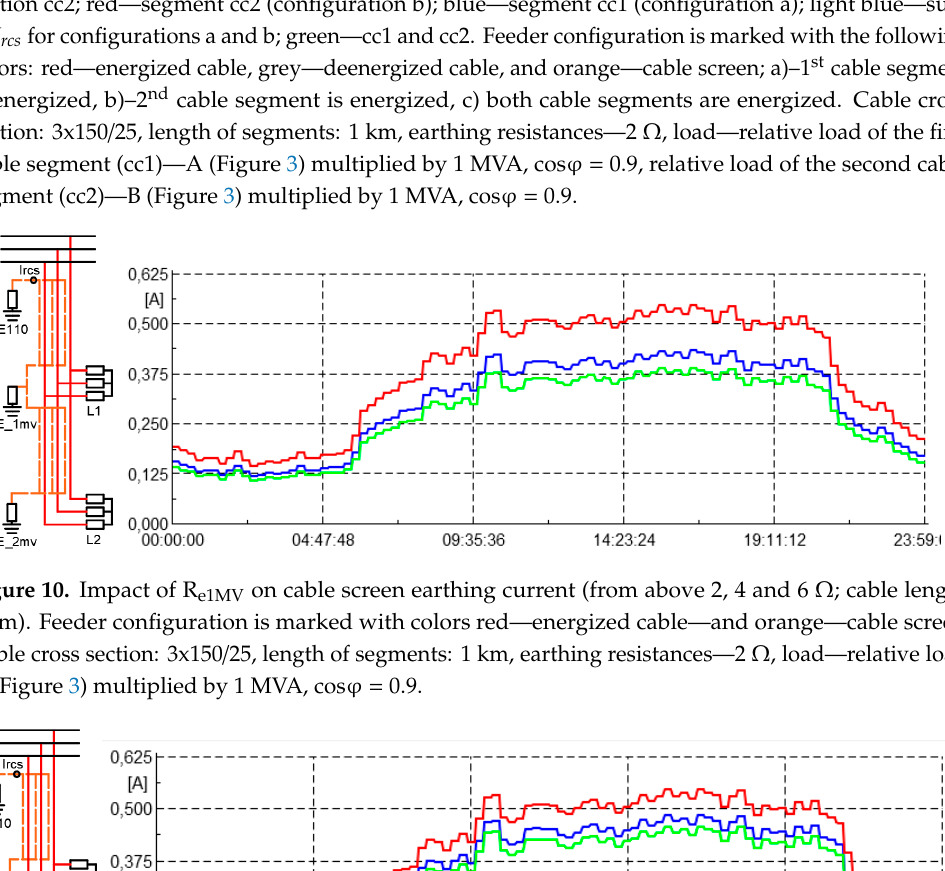
Figure 10. Impact of R e1MV on cable screen earthing current (from above 2, 4 and 6 Ω ; cable length 1 km).